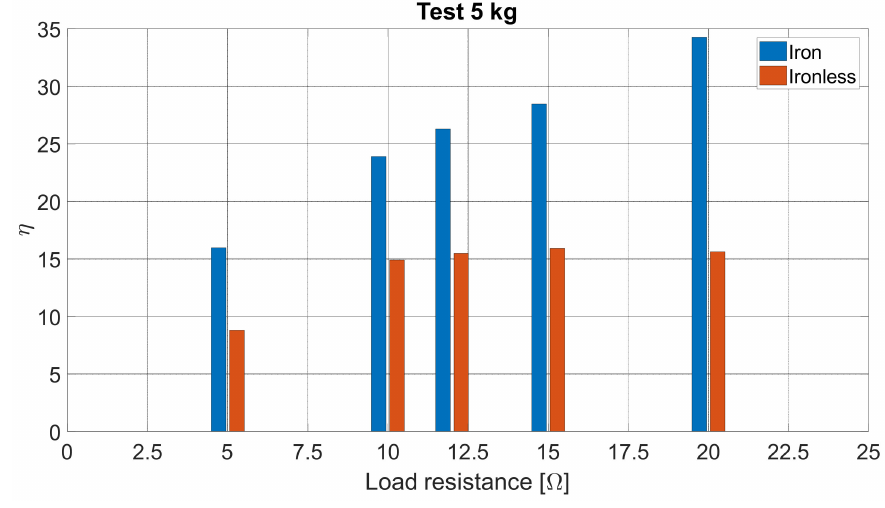
Figure 22. Efficiency comparison at 5 kg.